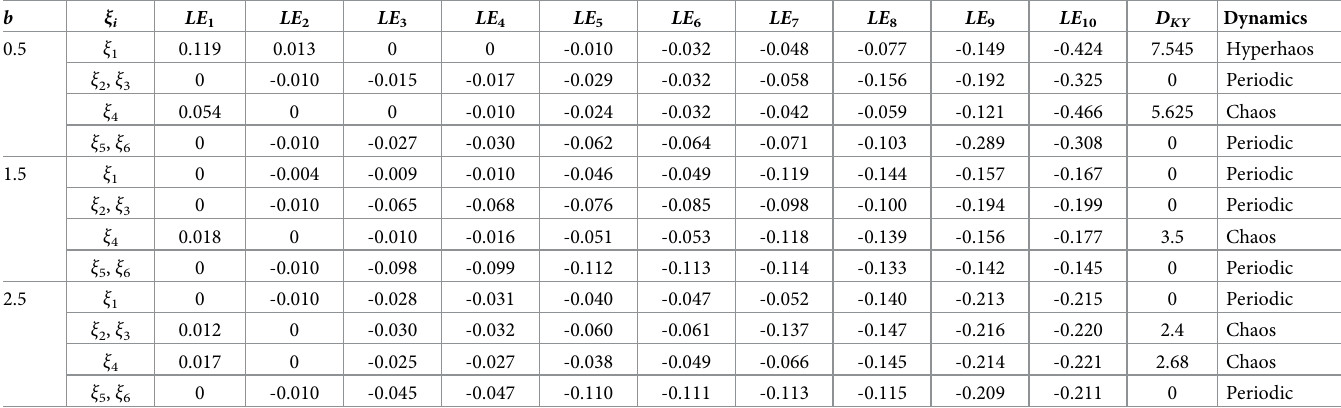
Table 7. Lyapunov exponents, Kaplan-Yorke dimensin and dynamics of system (1) coexisisting attractors with parameter b varying.